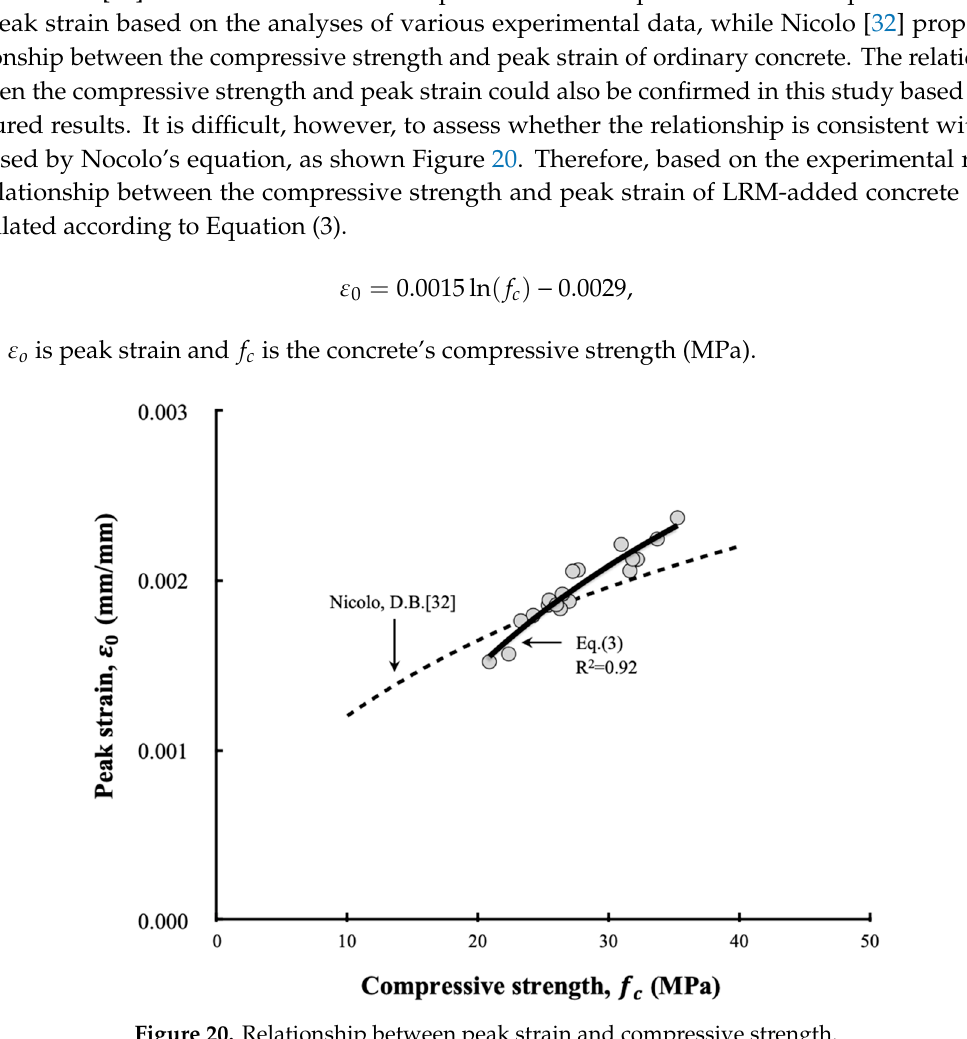
Figure 20. Relationship between peak strain and compressive strength.